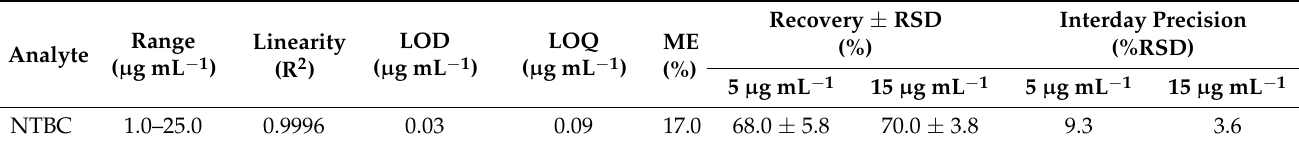
Table 1. Validation parameters for the elaborated method involving the new sorbent SG2_St_ β -CDMAh_EGDMA.